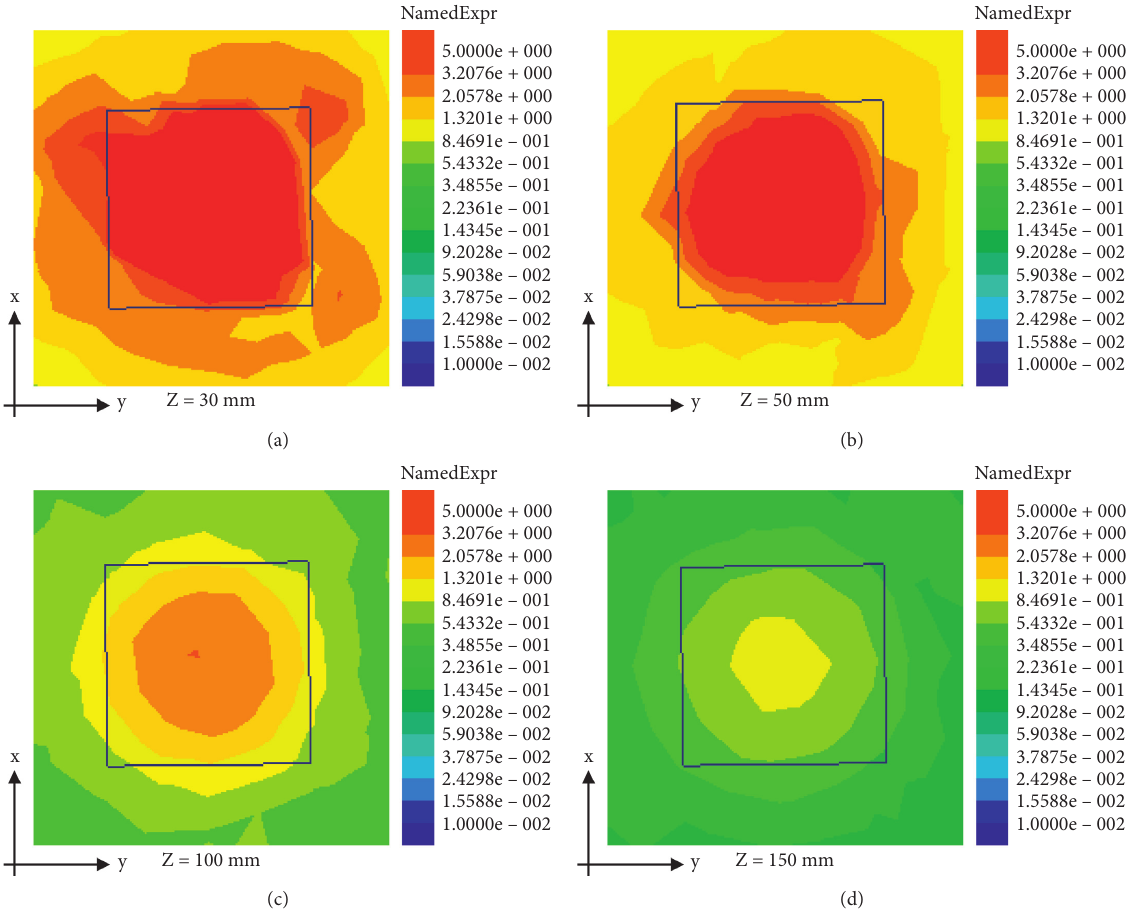
Figure 18: Simulated Ez distributions of the three-branch antenna at different heights when the dielectric constant is 1. (a) Z � 30mm. (b) Z � 50mm. (c) Z � 100mm. (d) Z �